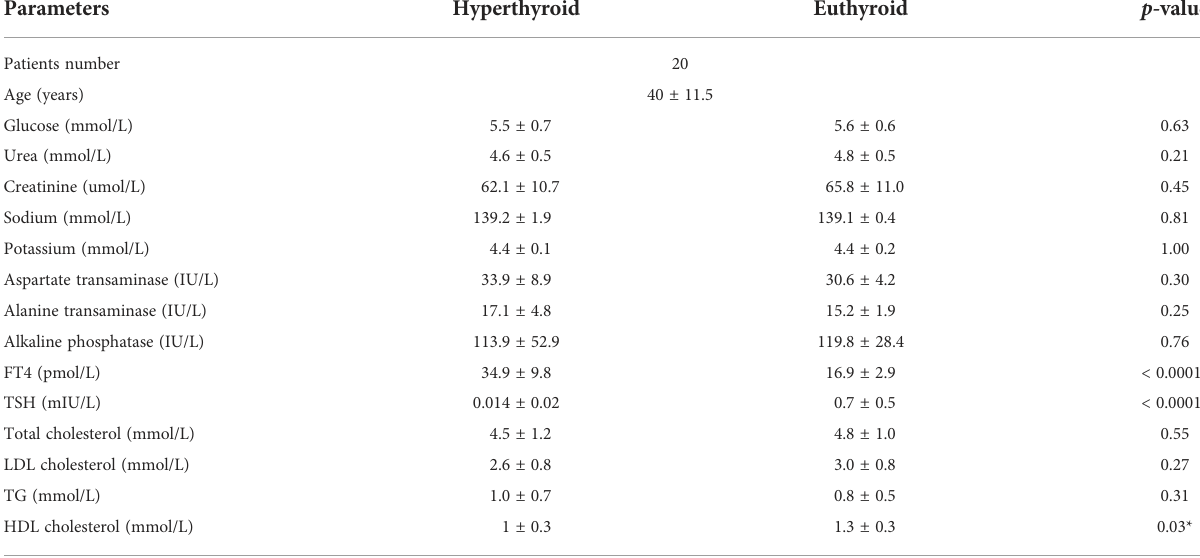
TABLE 1 Biochemical pro fi le of the hyperthyroid patients ’ pre- and post-treatment using carbimazole as antithyroid medication.